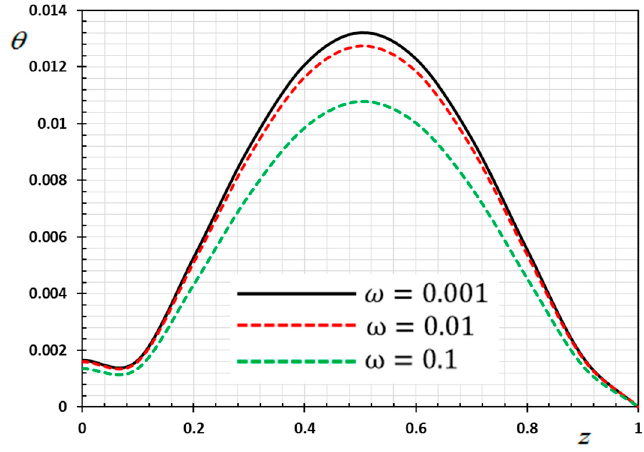
Figure 5. Variation of temperature 𝜃 versus 𝑧 for different delay time 𝜔 .